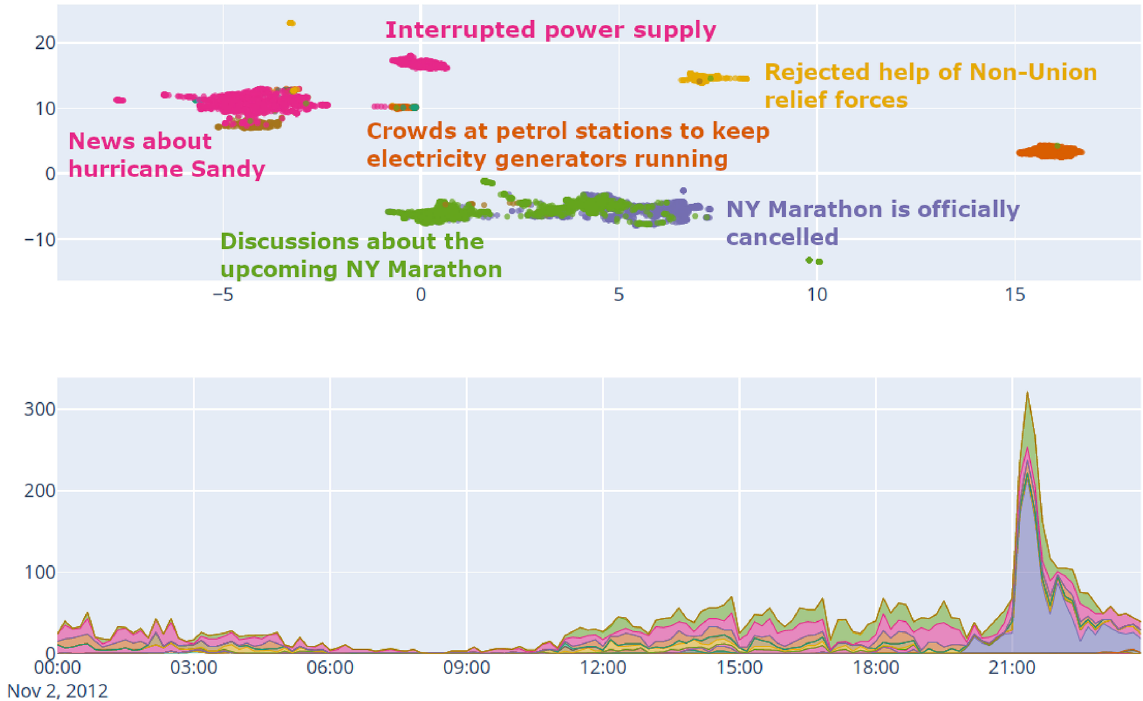
Figure 3. Top: 2D visualization of clusters containing the keyword “Long Island” identified on 14 October 2012 (arbitrary dimensions). Bottom: tweet counts over time (GMT) per cluster. Source: Bongard